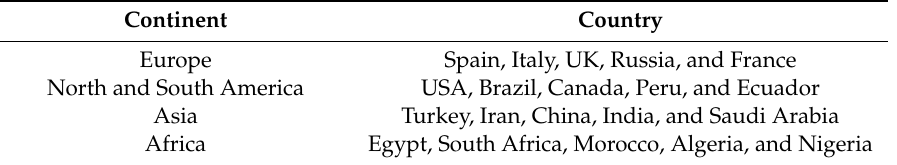
Table 1. Top five a ff ected countries in each continent.